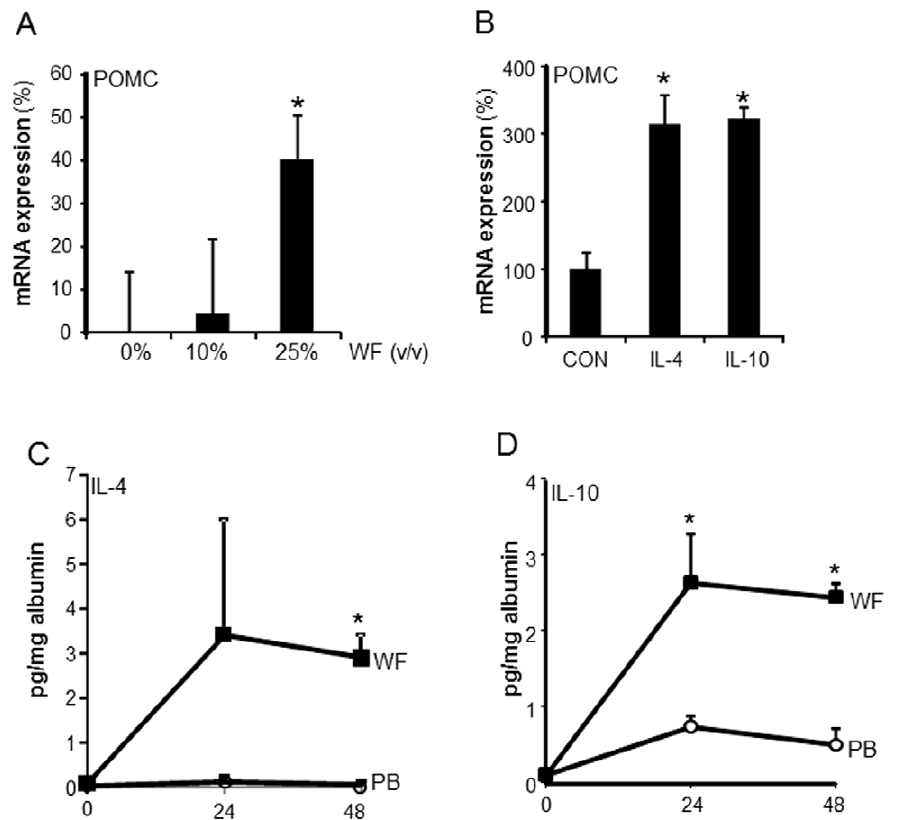
Figure 8. Sternal wound environment induces opioid peptide expression in PMN: presence of opioid inducing IL-4 and IL-10 in sternal wound environment. A, HL-60 cells were differentiated to PMN and then treated with varying dilutions (0–25%, v/v, 24 h) of wound fluid (WF) derived from sternal wounds. WF was sterile filtered and added directly to the PMN culture medium. POMC mRNA levels in WF treated PMN was measured using qPCR. Data are mean 6 SD (n=3).*, p , 0.05 compared to 0% treated cells. B , HL-60 cells were differentiated to PMN and then were treated with 100 ng/ml of IL-10 or IL-4 for 48 h. The expression of POMC transcripts were measured using qPCR. Data are mean 6 SD (n=3). * p , 0.05 compared to control. Both IL-4 and IL-10 that are abundantly present in WF significantly induced POMC mRNA expression. C , Levels of IL-4 and IL-10 in wound fluid (WF) and plasma were determined using ELISA at the indicated time points after surgery. The cytokine levels were normalized to the total albumin level in the fluid or plasma. Data are mean 6 SD (n=5). * p , 0.01 compared to plasma.